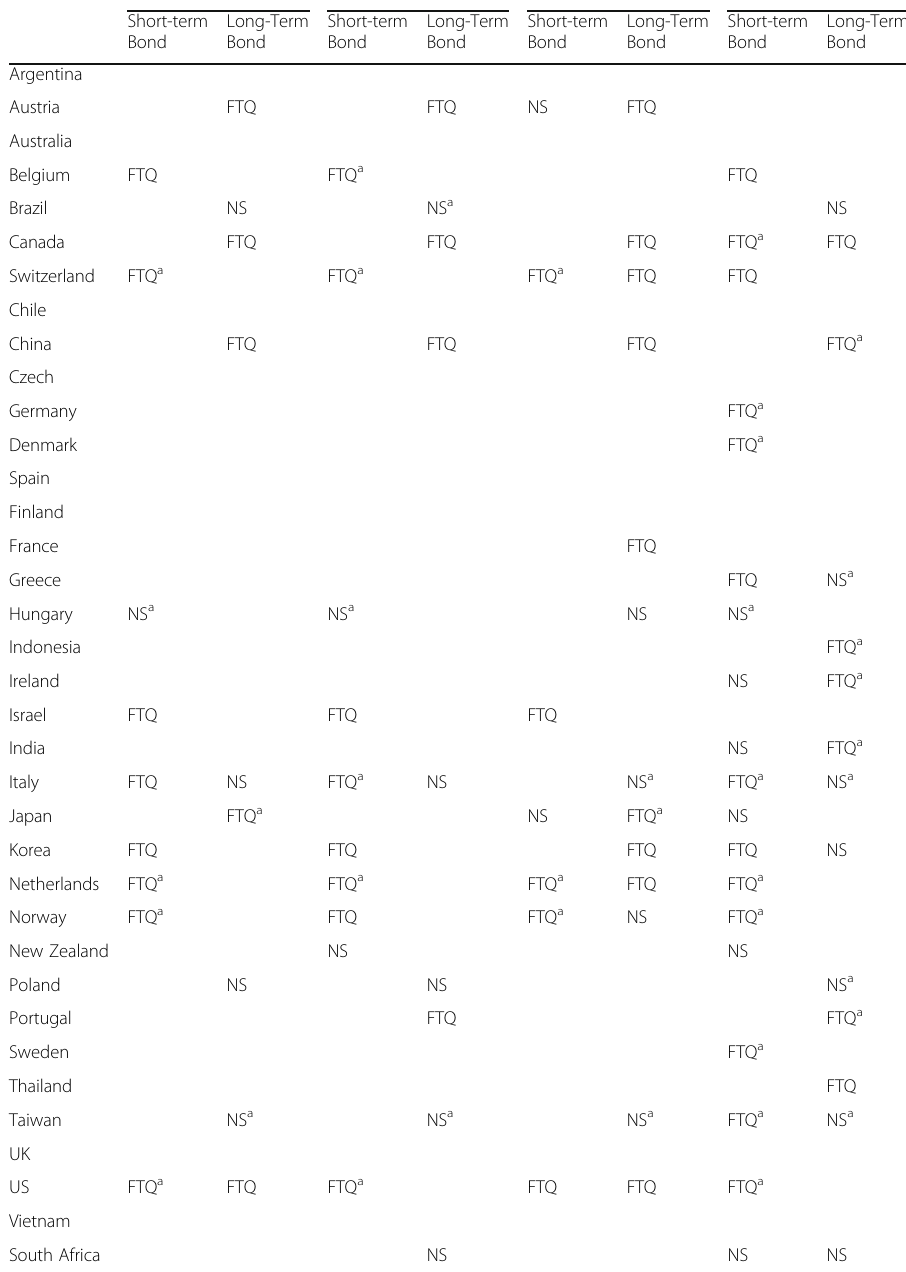
Table 8 Statistics to the different interdependences